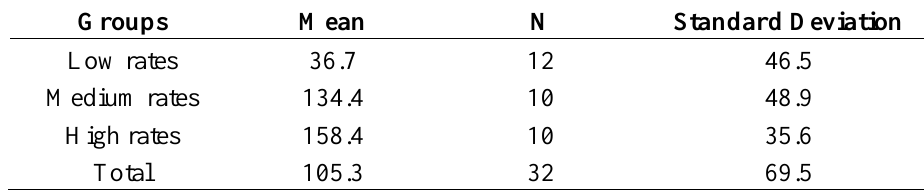
Table 5. Mean and standard deviations of the local vulnerability index according to groups given by the log-transformed